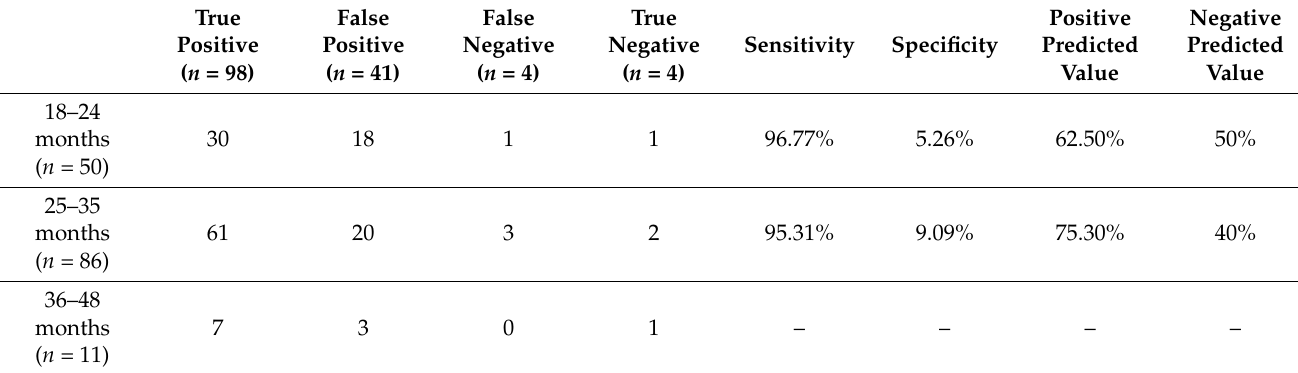
Table 5. Stability and diagnostic classification parameters at different ages.